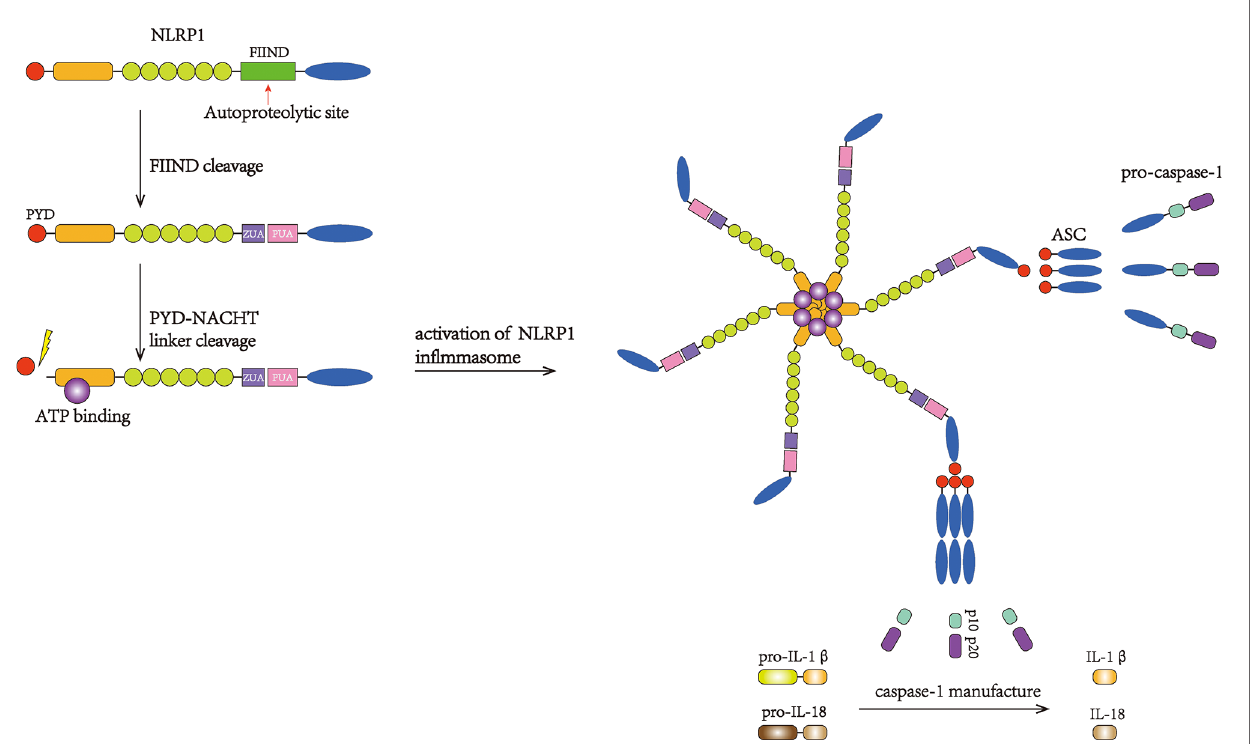
FIGURE 2 | Activation of the NLRP1 in fl ammasome. FIIND is autocleaved to activate NLRP1. Then, PYD undergoes cleavage, and the in fl ammasome complex subsequently forms, suggesting that PYD may play an autoinhibitory role. The binding of ASC can recruit pro-caspase-1. Then, pro-caspase-1 undergoes autocatalytic cleavage and forms the p10 and p20 subunits, which initiate the maturation and secretion of IL-1 b and